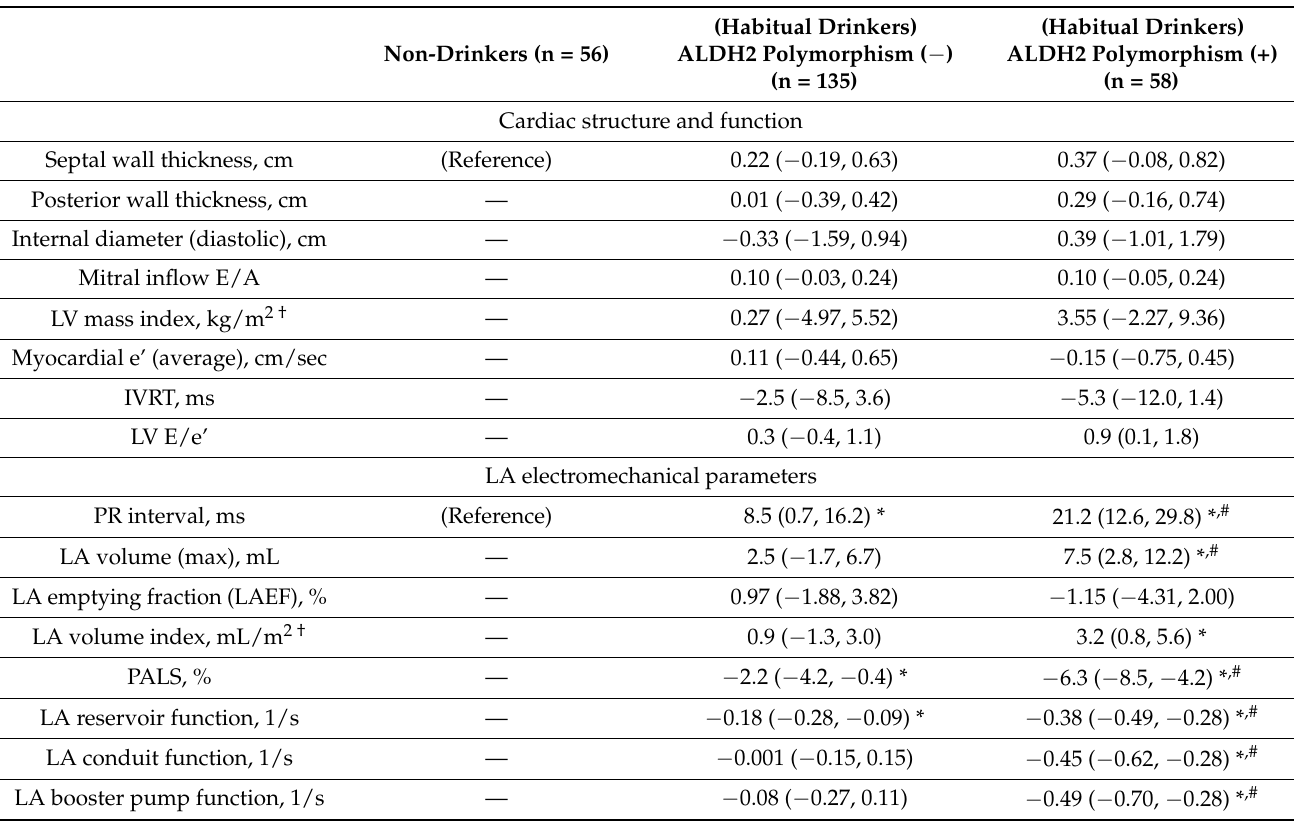
Table 3. Adjusted regression models that were used for examining the cardiac structure and novel LA mechanical parameters across non-drinkers and habitual drinkers without and with the presence of ALDH2